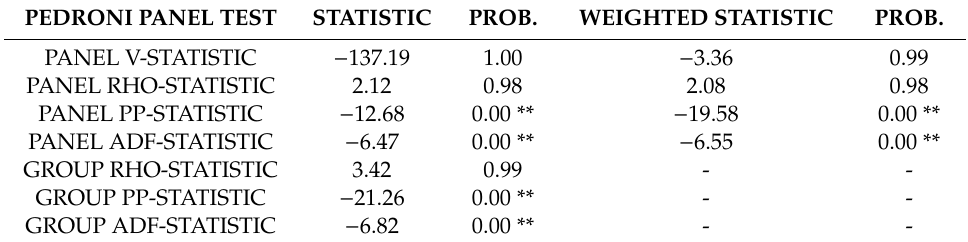
Table 5. Robustness check for the cointegration test (Pedroni Panel